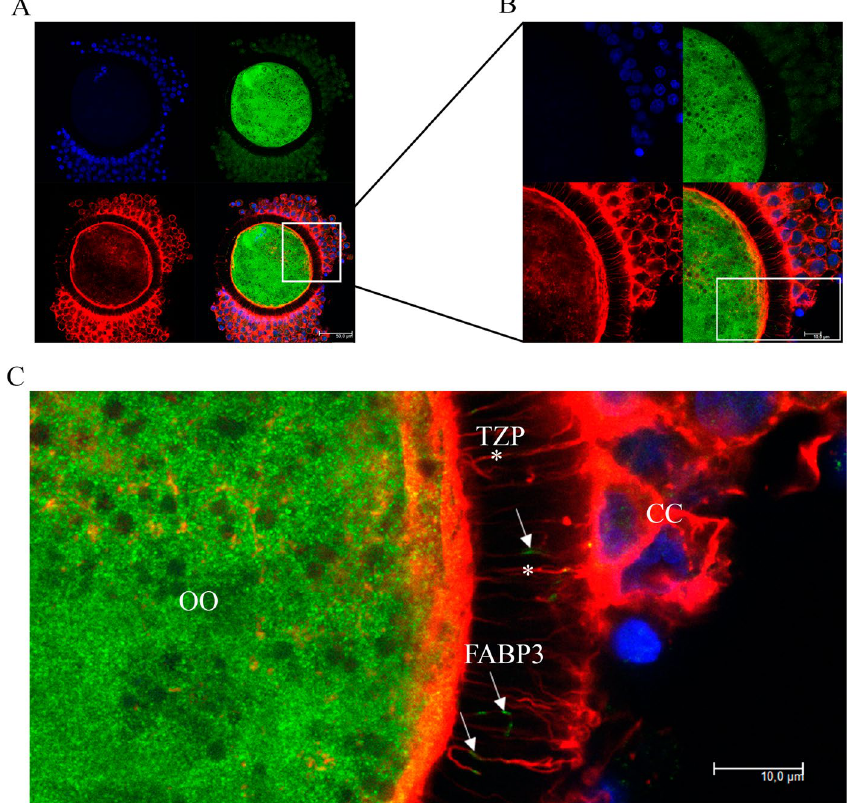
Figure 2. Confocal microscopic analysis demonstrating the presence of fatty acid binding protein 3 (FABP3) within the transzonal projections (TZPs) of immature cumulus-oocyte-complexes (COCs). FABP3 was immunostained using 488 Alexa Fluor (green); TZPs (actin) were labeled with Alexa Fluor 647 phalloidin (red) and nuclei were stained with DAPI (blue). ( A ) Photomicrographs of immature COCs were obtained in 63 x objective and ( B ) in 63 x objective zoomed 3.5 x. ( C ) Digital zoom showing FABP3 (arrow) within TZPs (asterisk) in zona pellucida (OO = oocyte; CC = cumulus cells). A total of 12 immature COCs were analysed and showed similar pattern; 6 additional COCs are shown in Supplementary Fig.